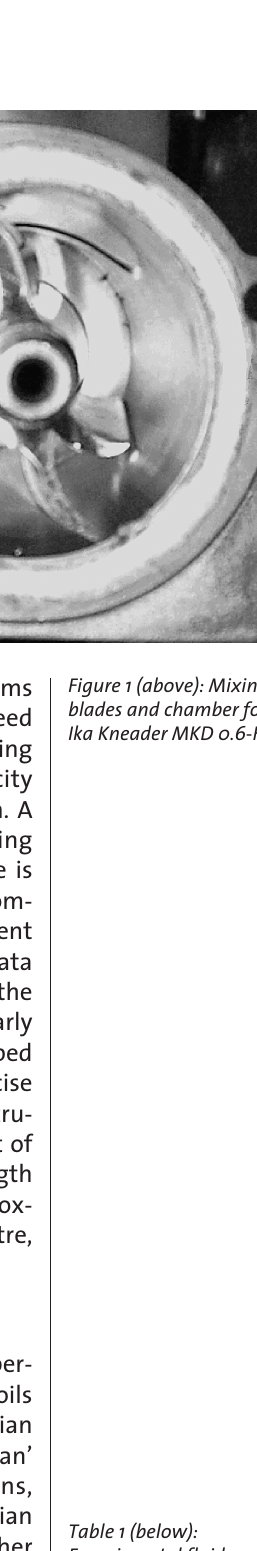
Table 1 (below): Experimental fluids